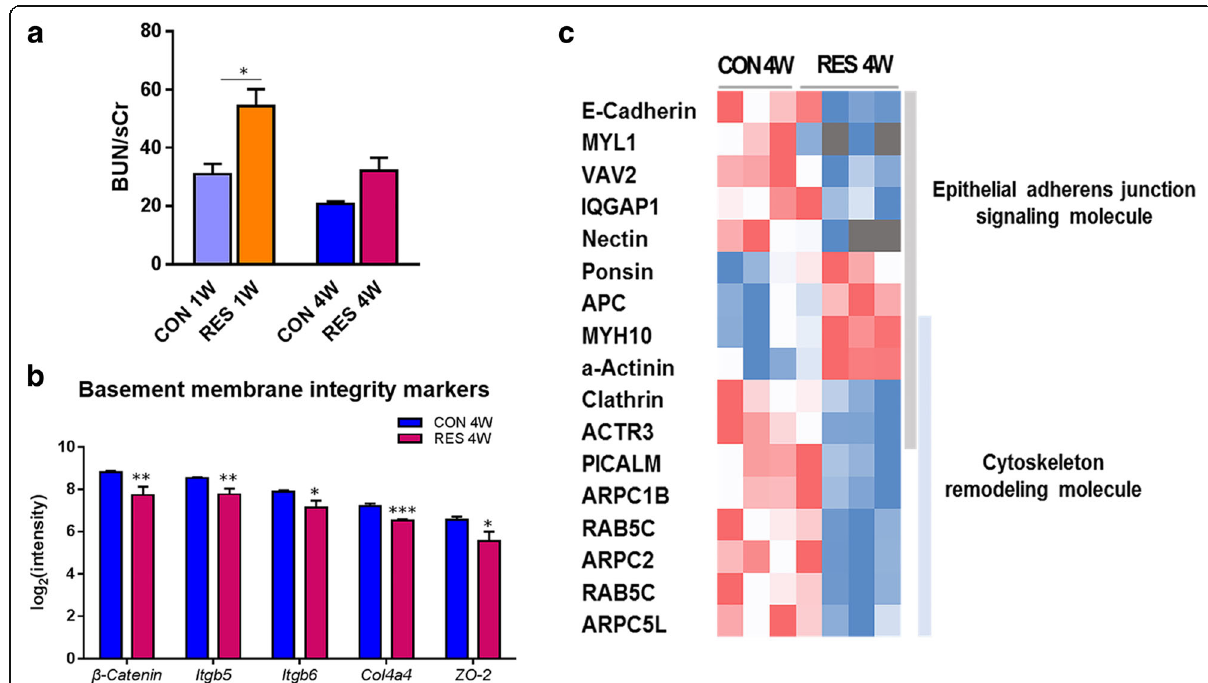
related to cell-cell junction and cytoskeleton rearrangement underlying altered membrane integrity. Data are expressed as mean ± SEM. Student ’